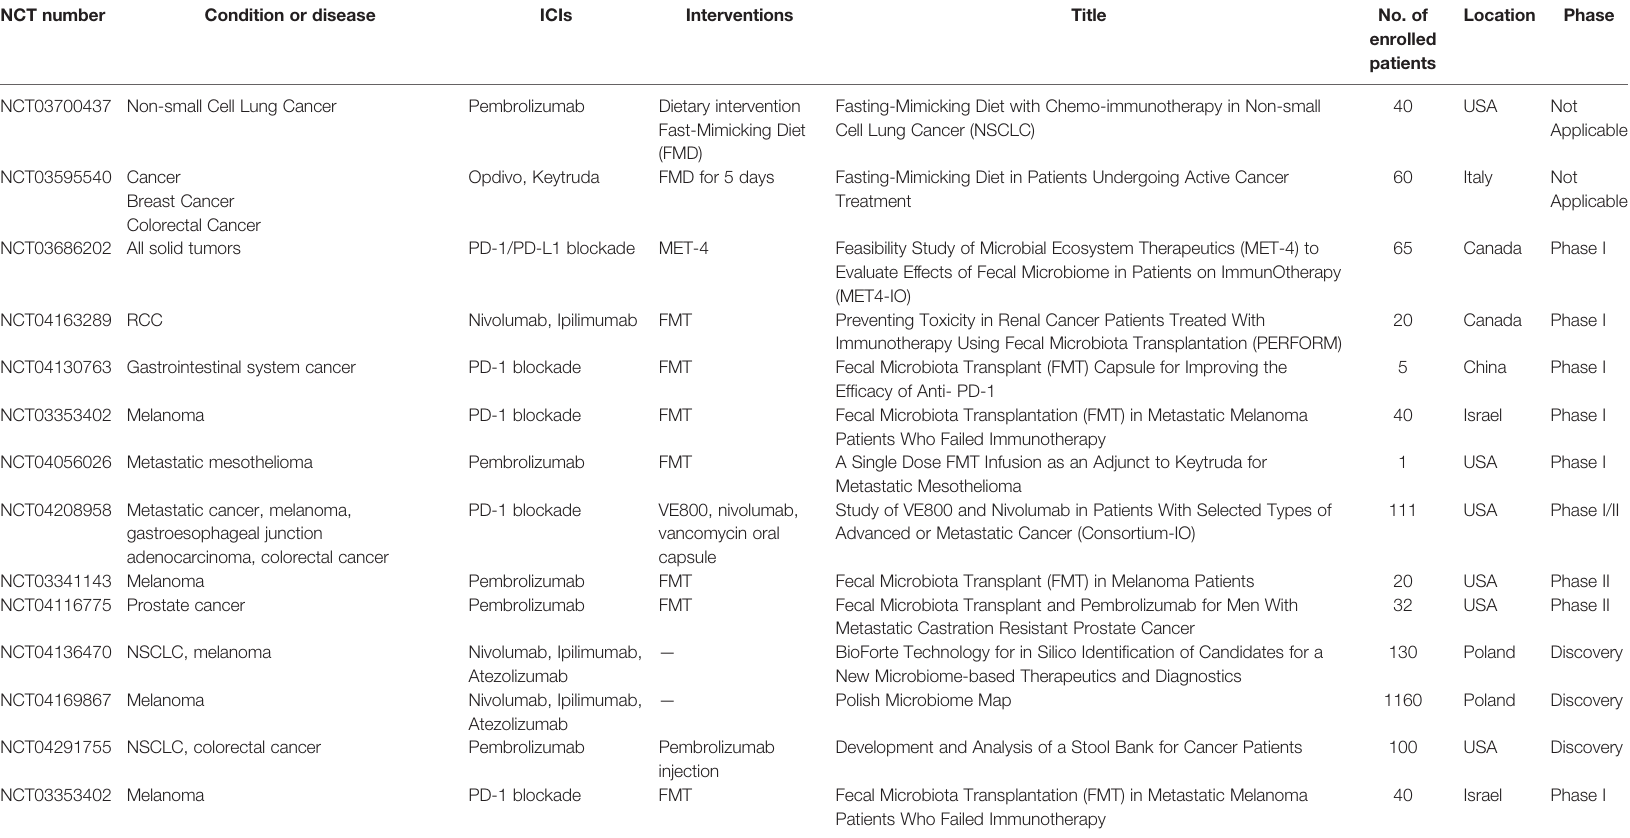
TABLE 2 | Clinical trials on gut microbiota and